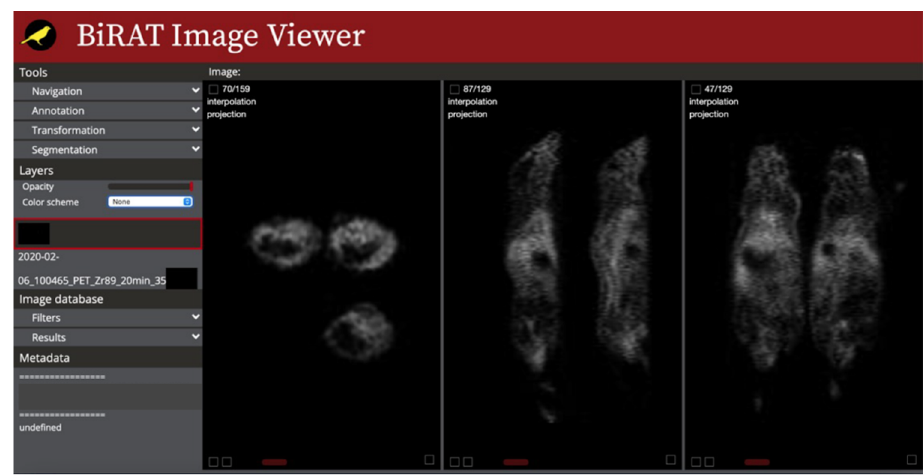
Figure 5. Screenshot of the application image viewer.